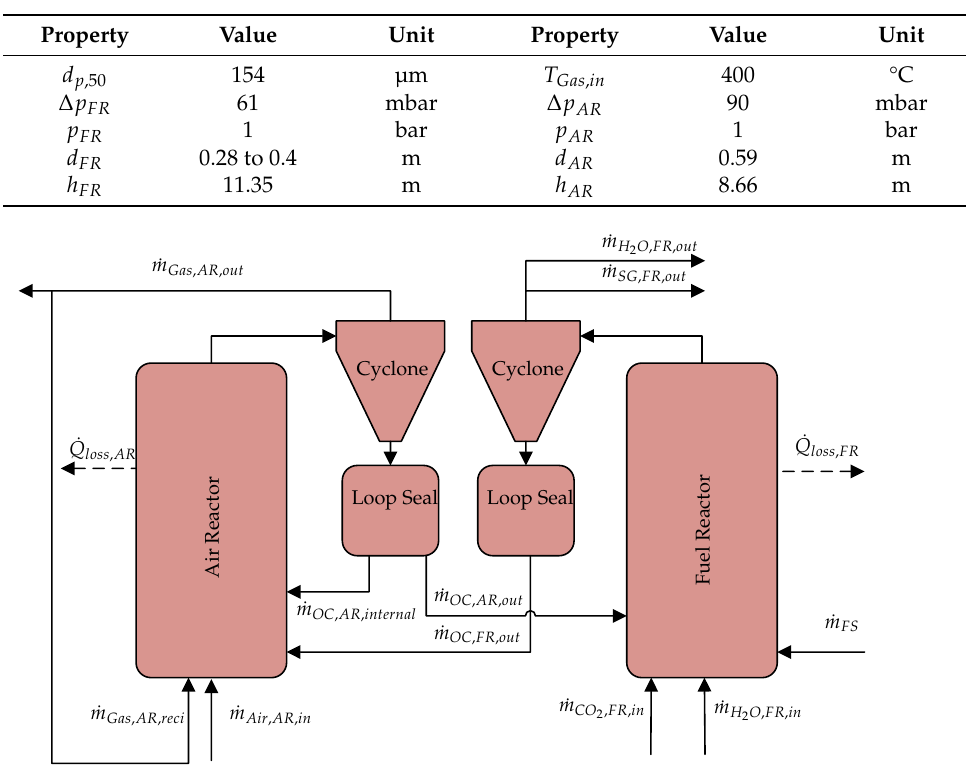
Figure 2. Streams for the calculation of mass and energy balances of the CLG